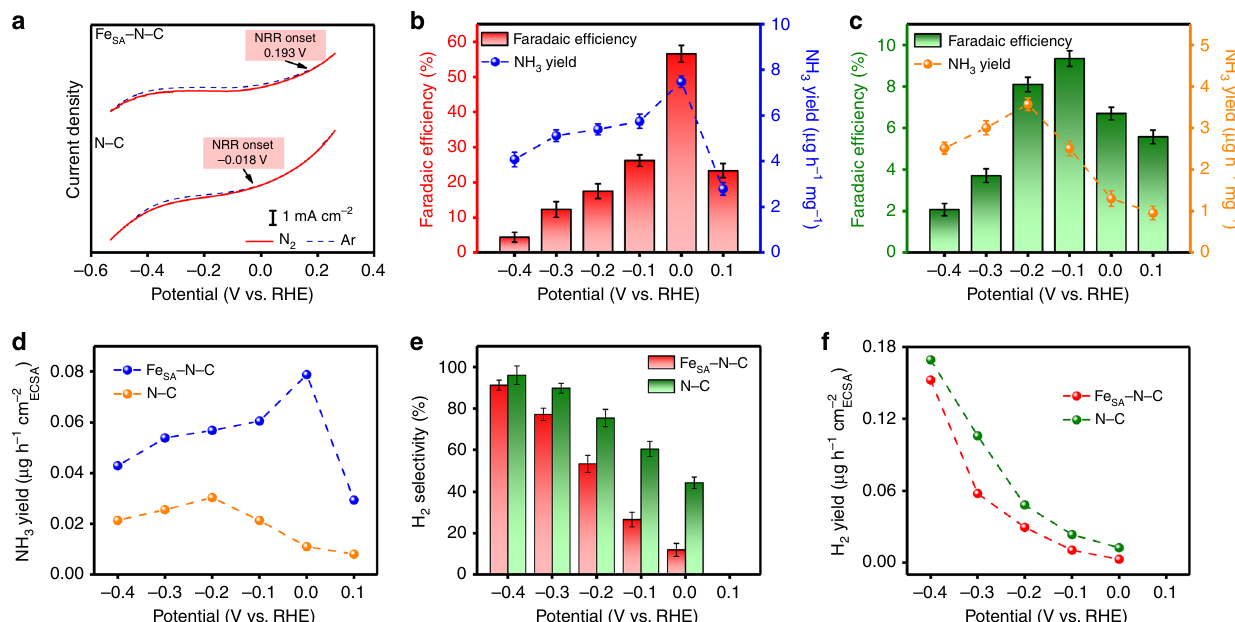
Fig. 2 Electroreduction of N 2 to NH 3 at ambient conditions. a Linear sweep voltammograms of single-atom dispersed Fe – N – C (Fe SA – N – C) and nitrogen- doped carbon (N – C) in Ar-saturated (dashed line) or N 2 -saturated (solid line) 0.1 M KOH solution with a scan rate of 50 mV s − 1 . b NH 3 Faradaic ef fi ciencies and mass-normalized yield rates at each given potential of Fe SA – N – C. c NH 3 Faradaic ef fi ciencies and mass-normalized yield rates at each given potential of N – C. d Surface-area-normalized yield rate of NH 3 production at different applied potentials on Fe SA – N – C and N – C. e H 2 selectivity of Fe SA – N – C and N – C at different potentials. The error bars correspond to the standard deviations of measurements over three separately prepared samples under the same conditions. f Surface-area-normalized yield rate of H 2 production at different applied potentials on Fe SA – N – C and N – C